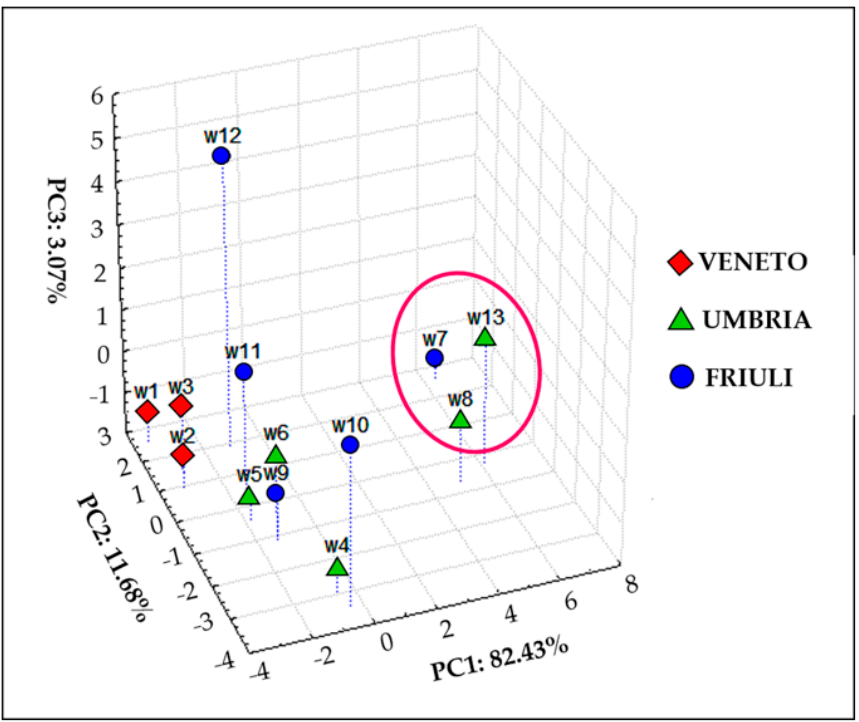
Figure 6. Scatter plot (for PC1, PC2 and PC3) obtained from PCA carried out on the 32 polyphenol concentrations.